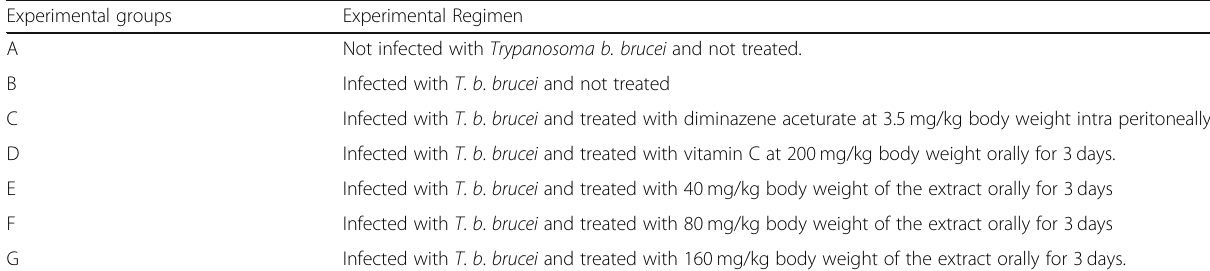
Table 1 Experimental grouping of rats and the experimental regimen Experimental groups Experimental Regimen